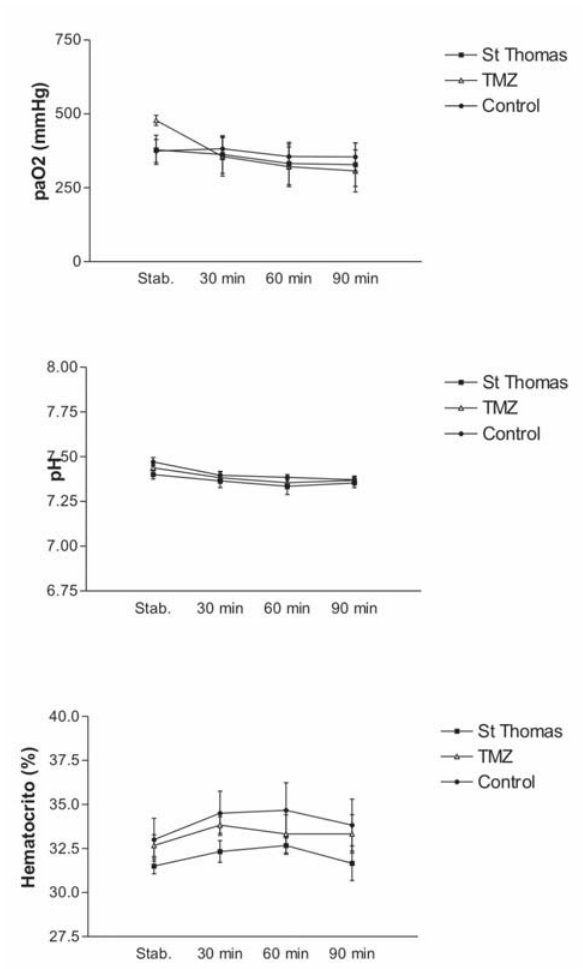
Fig. 3 - Pressão parcial de oxigênio (pO2a) (acima), pH (médio) e hematócrito (abaixo) dos animais suporte ao longo do procedimento. Dados apresentados como média e dois erros padrão da média (EPM) (n = 6) em cada grupo